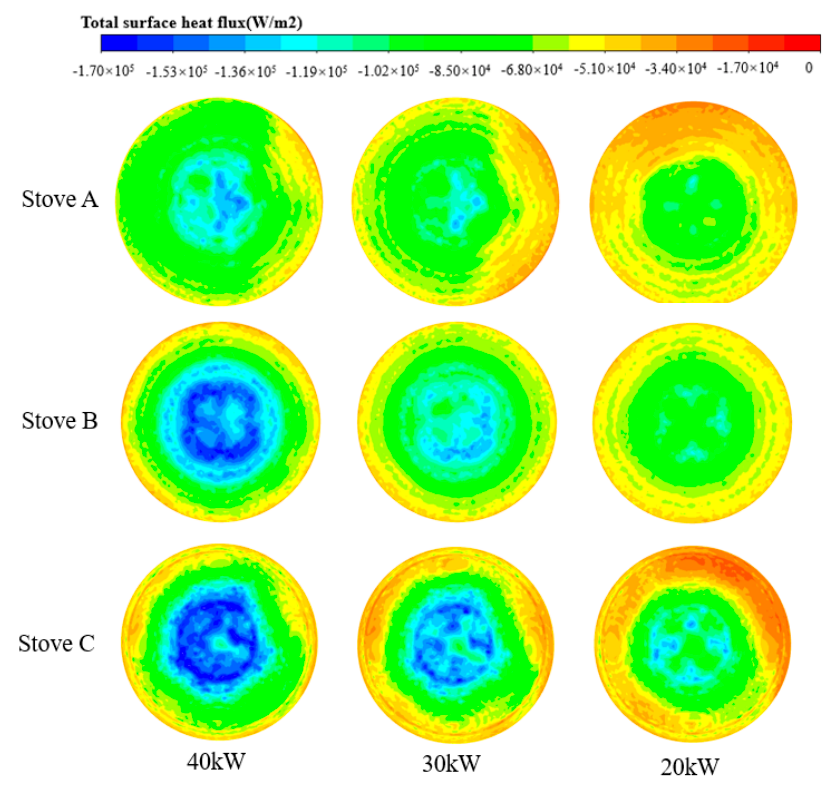
Figure 9. Heat flux uniformity index of the three stoves at different power rates.